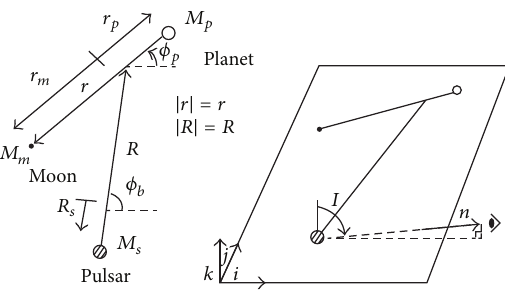
Figure 1: Distribution of the vectors used in this paper and the plan of the orbit containing the pulsar-planet